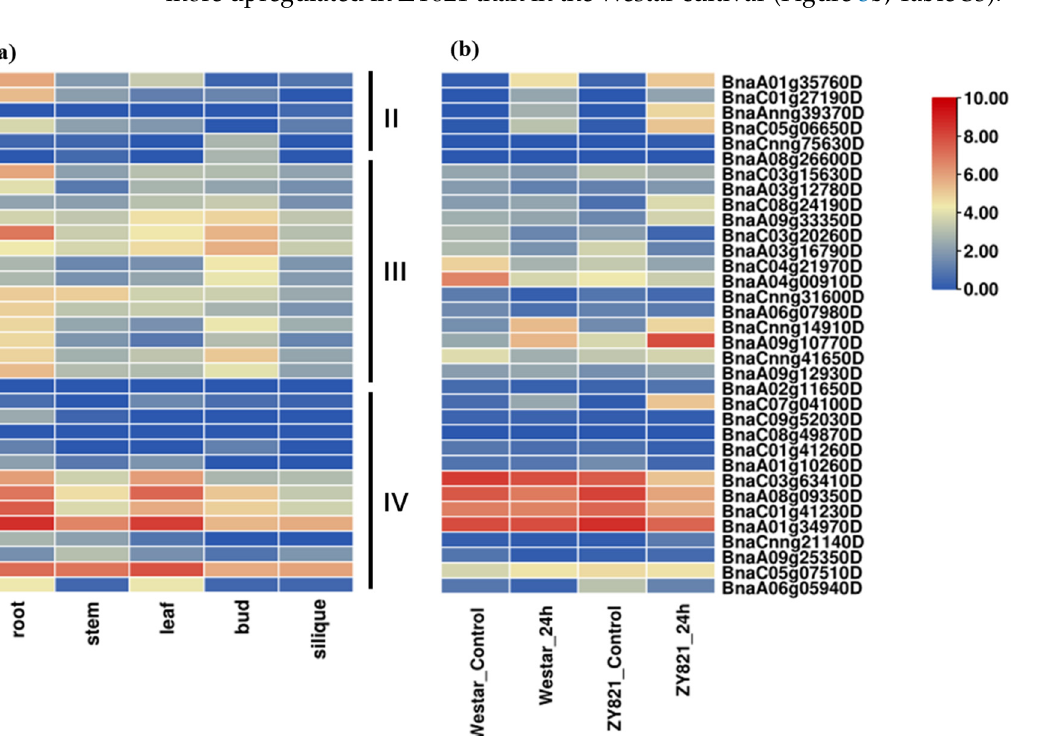
Figure 4. The expression validation of 12 candidate BnPP2 genes in response to S. sclerotiorum by qRT-PCR. The time points 0 h, 12 h, 24 h, 36 h and 48 h represent hours after inoculation with S. sclerotiorum . The error bars show the standard error of three replicates.